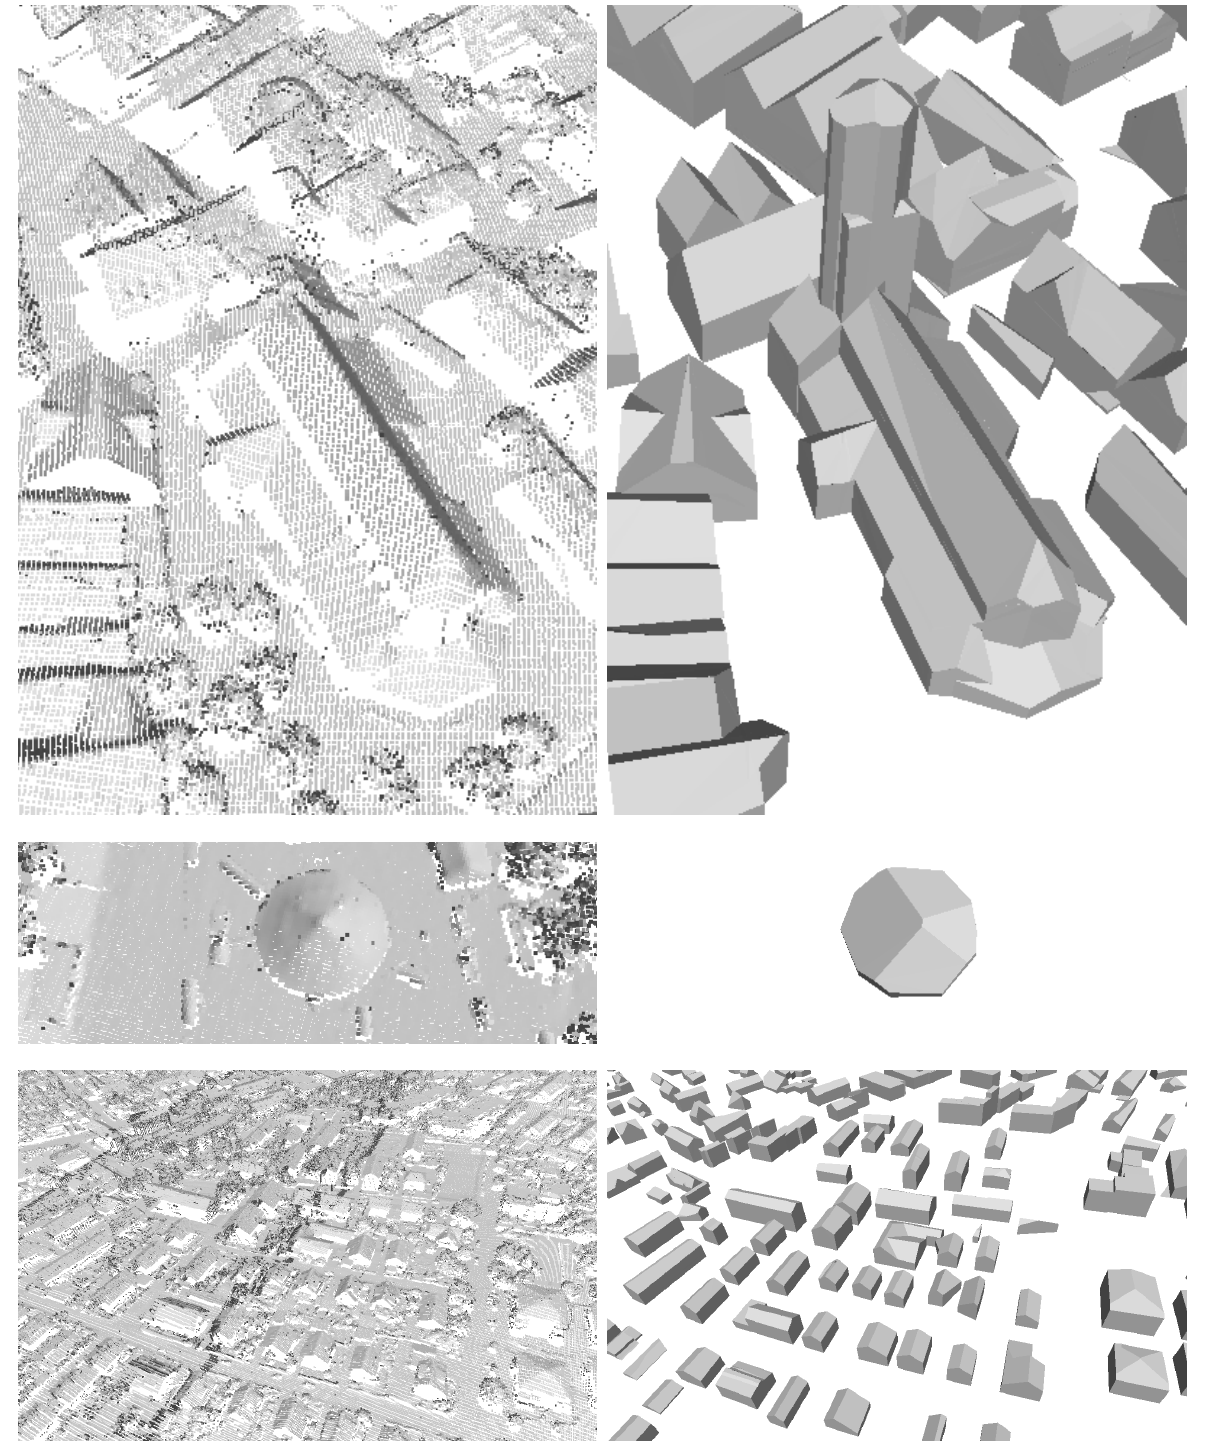
Figure 4. Close-ups on the reconstructed models. From top to bottom : church (Biberach), tent (Biberach), residential area